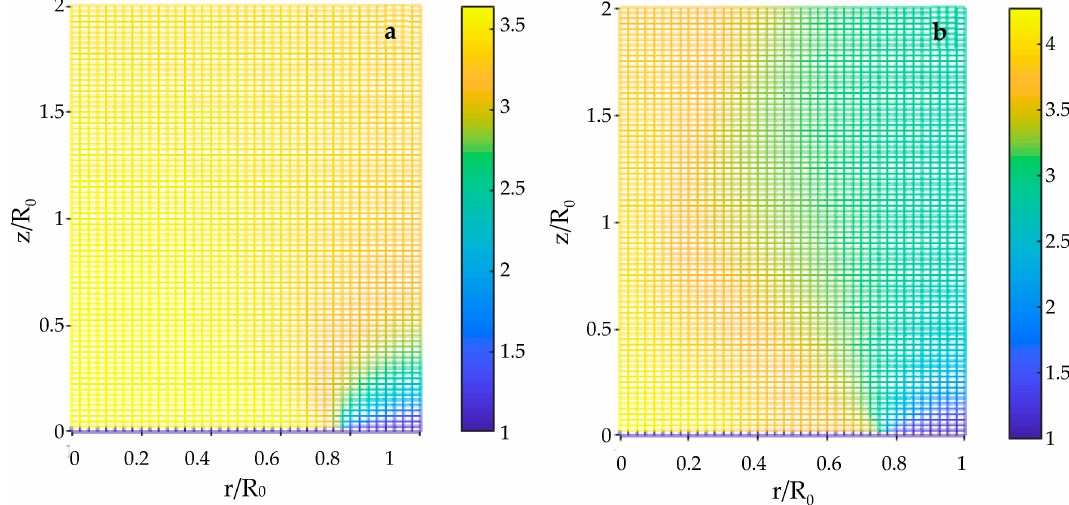
Figure 12. Electric field e ff ect on the temperature development at P e = 0 ( a ) and P e = 2.5 ( b